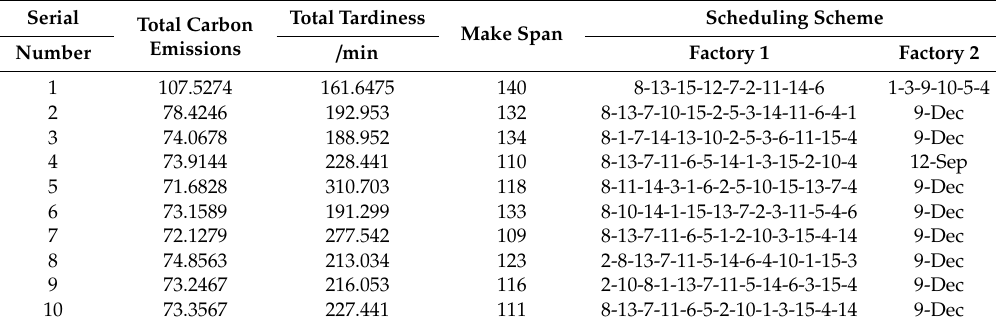
Table 12. Pareto solutions and corresponding jobs-to-factories allocation scheme (part).